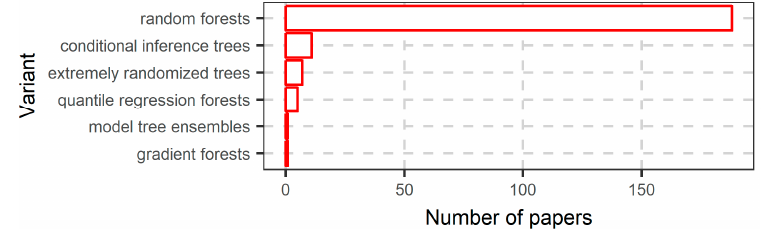
Figure 9. Number of published papers implementing random forests and their variants.